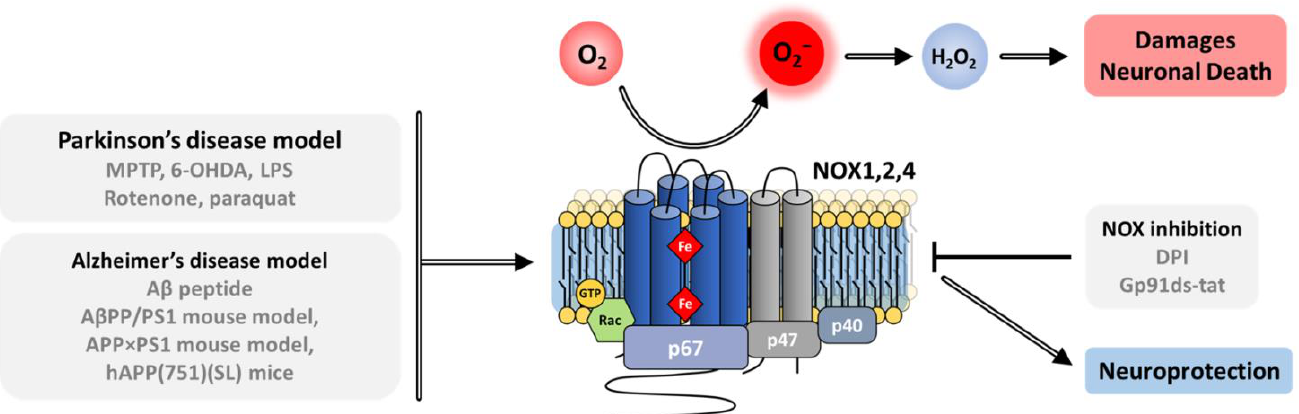
Figure 19. NOX-mediated neurodegeneration and neuroprotection. In Parkinson’s and Alzheimer’s disease models, the ROS overproduction resulting from the activity of NOX family contributes to neurodegeneration. NOX inhibition mediated by apocynin, DPI or Gp91ds-tat induces neuronal protection. Figure is inspired by [376].